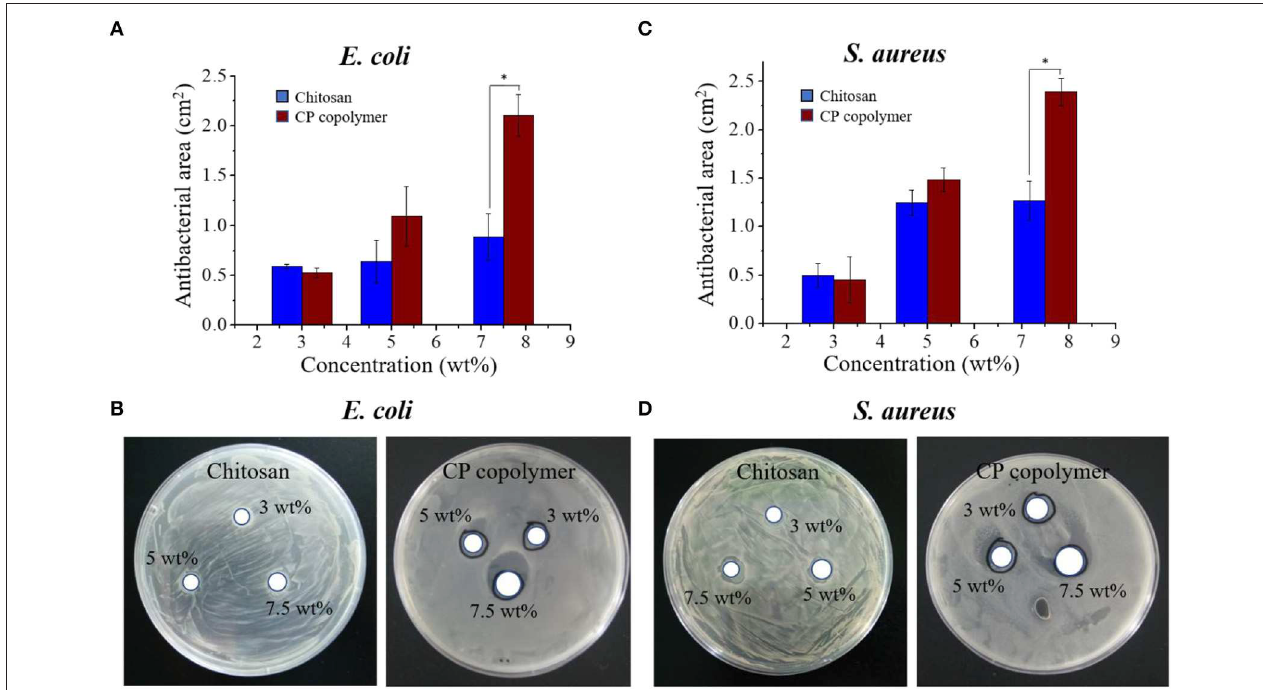
FIGURE 2 | (A) The antibacterial activity of the CP copolymer and chitosan against E. coli as determined by the antibacterial area during culture (24h, 37 ◦ C). (B) The antibacterial activity of the CP copolymer and chitosan against S. aureus as determined by the antibacterial area during culture (24h, 37 ◦ C). (C) The quantitative data analysis for (A) . (D) The quantitative data analysis for (B) . * p < 0.05.